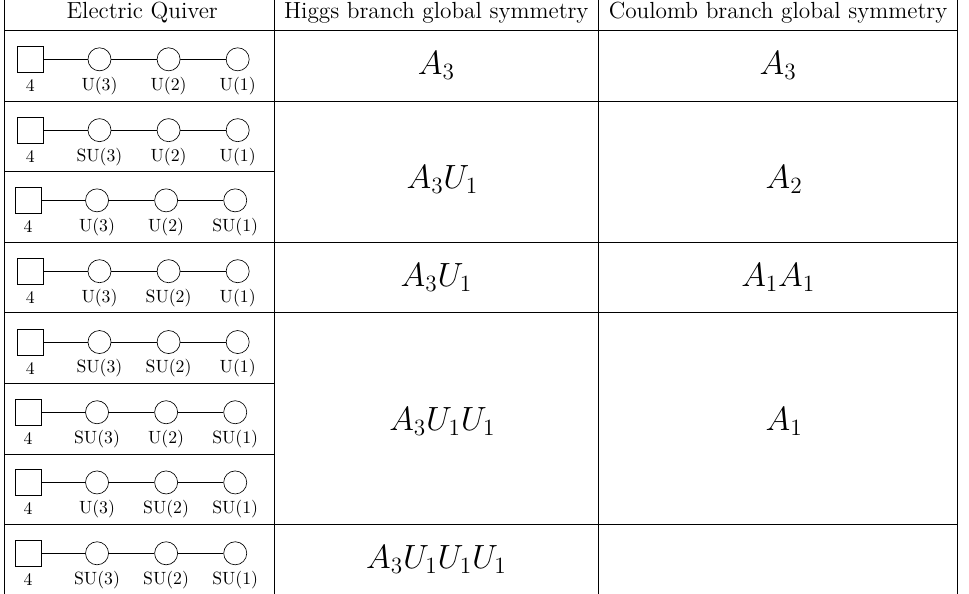
Table 4 . Extensions of the T (SU(4)) quiver are shown with different combinations of U/SU nodes, along with their Higgs and Coulomb branch global symmetry. Notice that the ranks of the global symmetries always add to 6